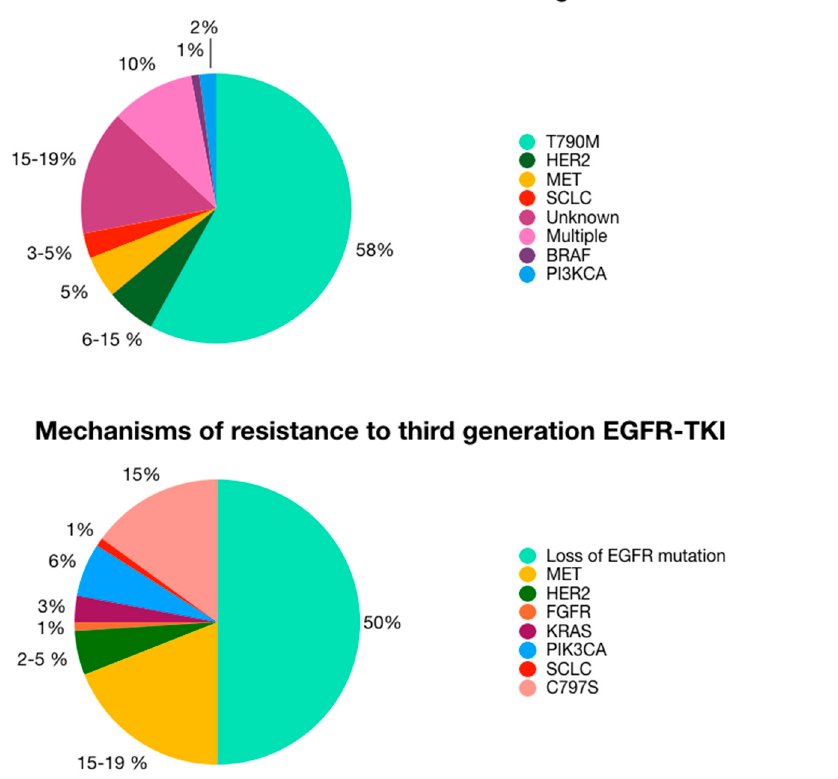
Figure 1. Mechanisms of resistance to EGFR-TKIs and their frequencies. Human Epidermal Growth Factor Receptor 2 ( HER2 ), Mesenchymal Epithelial Transition [ MET ], Small Cell Lung Cancer (SCLC), RAF murine sarcoma viral oncogene homolog B1 ( BRAF ), Phosphatidyl-Inositol 4,5-bisphosphate 3-Kinase Catalytic subunit Alpha ( PI3KCA ), Kirsten rat sarcoma ( KRAS ), Fibroblast Growth Factor Receptor ( FGFR